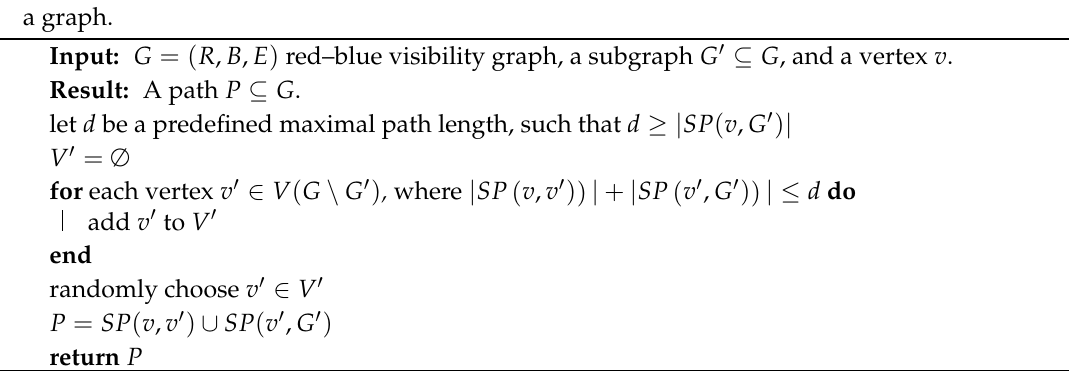
Algorithm 3: Pseudocode of f indPath , which finds a random path connecting a new vertex to a